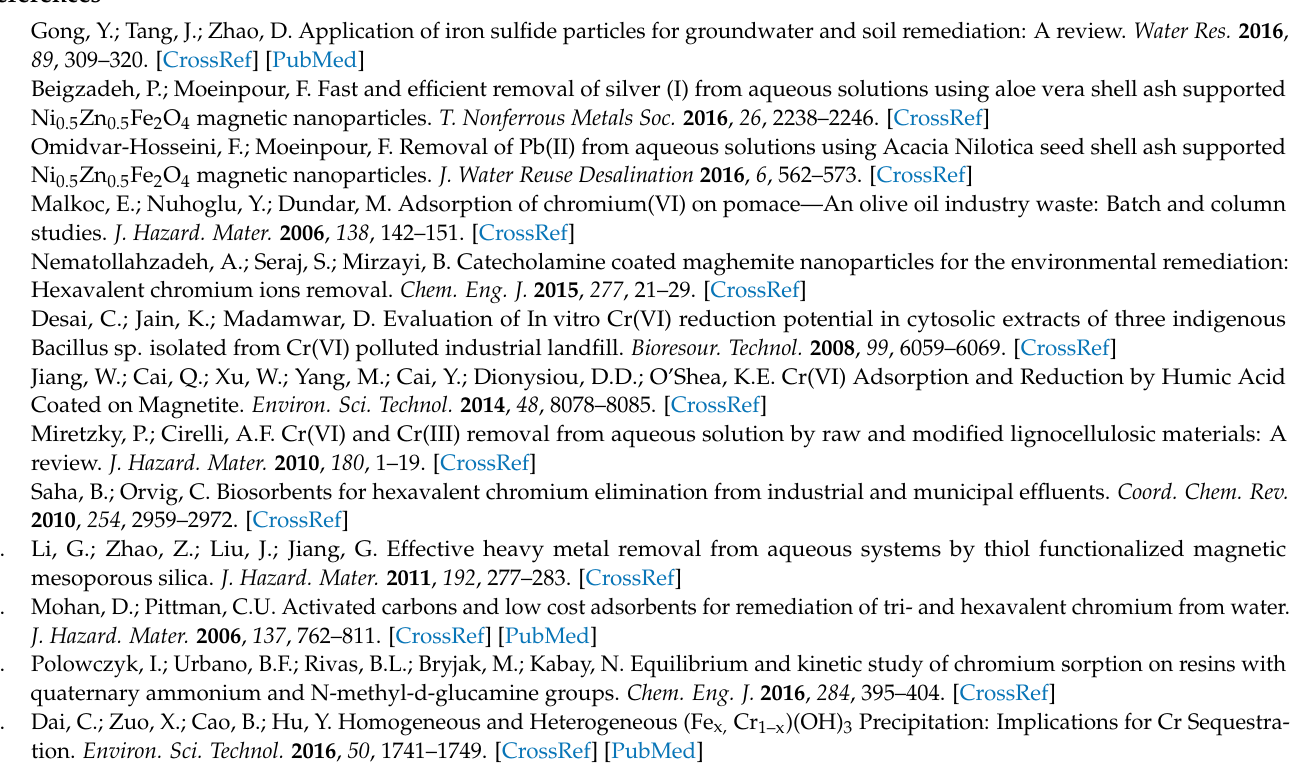
Table S1: The pseudo-second-order and the first-order model parameters; Table S2: The parameters of the Langmuir model and Freundlich